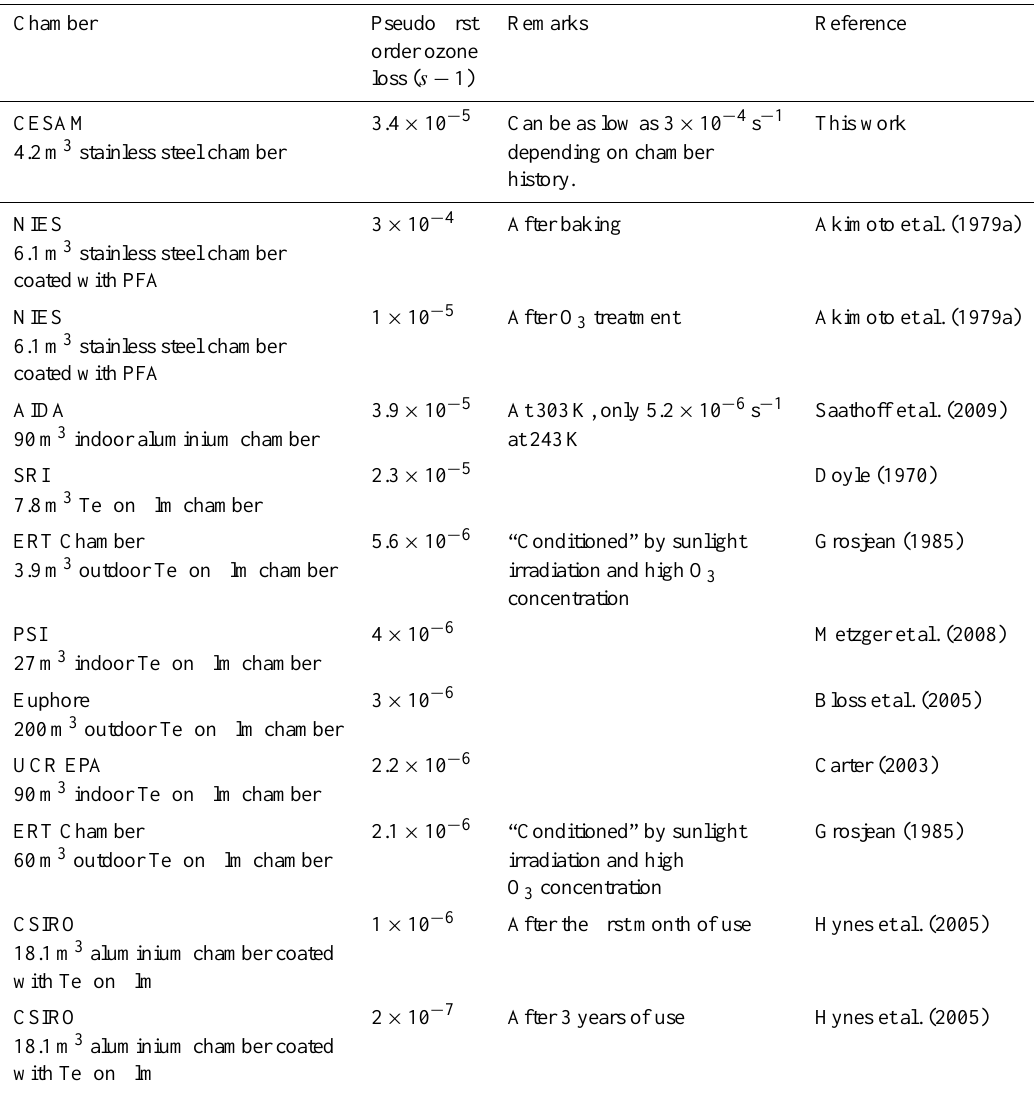
Table 6. Comparison for the dark ozone wall loss rate in chambers under dry